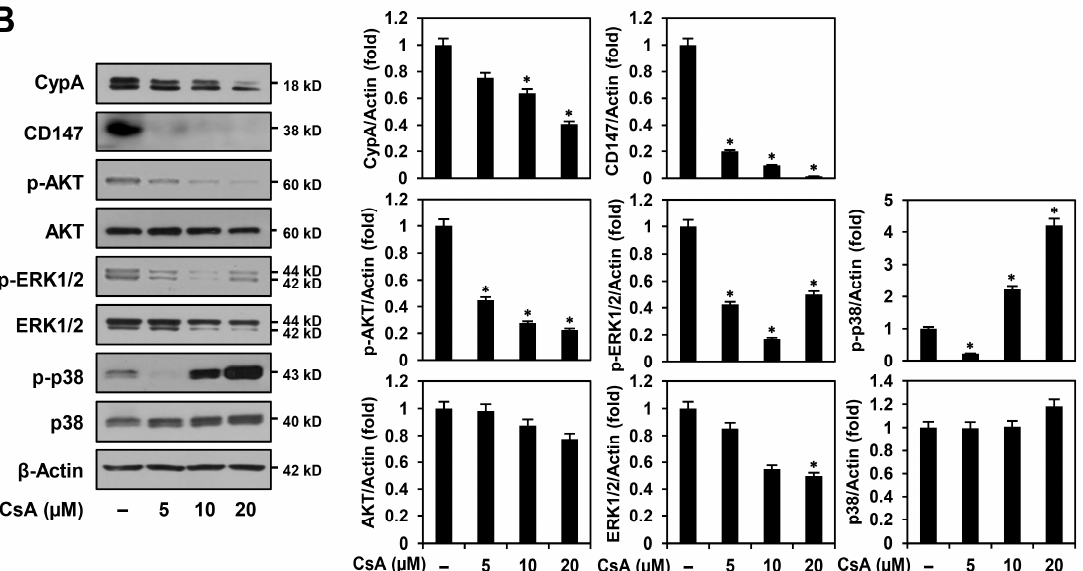
Figure 8. Effects of C9 and CsA on the CypA/CD147-mediated signaling pathways in MKN45 GCSCs. ( A , B ) MKN45-derived GCSCs were treated with the indicated concentrations of each compound for 72 h. Protein levels were detected via Western blot analysis using specific antibodies and were further quantified using densitometry. β -actin levels were used as an internal control. The ratio of each target protein to β -actin for untreated control was normalized to onefold. * p < 0.05 vs. the